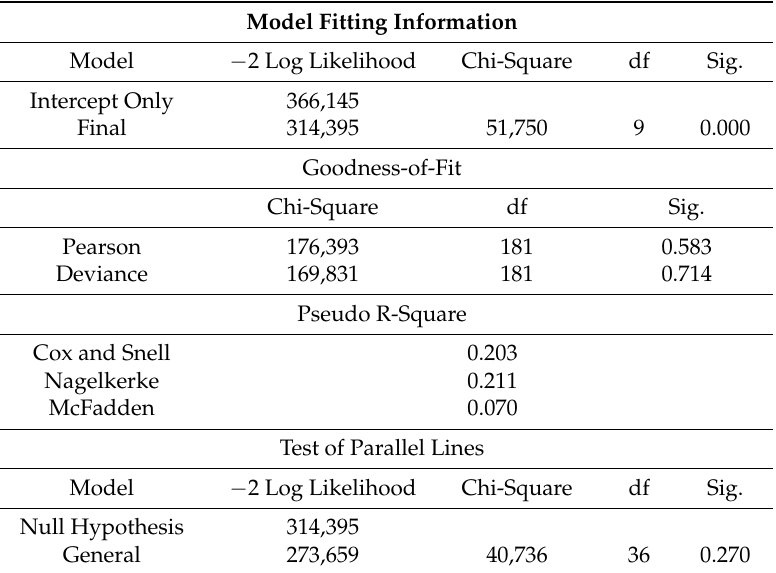
Table 1. Overall fitting indices for the private car